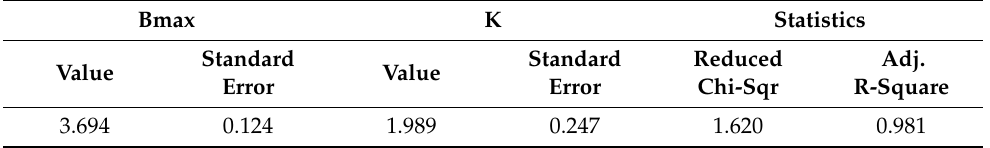
Figure 7. The ( A ) transmission spectra of SPR-POF platform functionalized with specific antibody (IgG AMY) and tested with amylase in surgically-placed drain effluent solution, ( B ) plasmon resonance wavelength variation ( ∆ λ ), with respect to the blank, versus the concentration of amylase content in drain effluent solution (U/L), and ( C ) linear fitting of data (mean value) obtained by two independent POF-biosensor batches. Error bars represent the standard deviation of measurements carried out on three different POF-biosensors prepared from three different batches. Table 2. Langmuir parameters of amylase detection in real solution by the SPR-POF